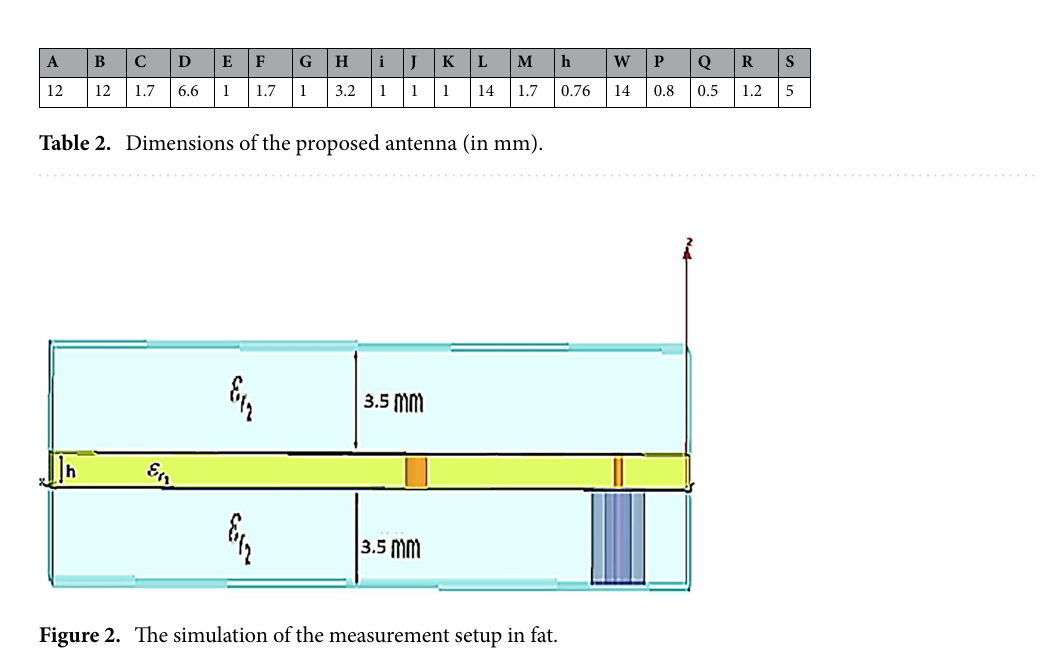
Figure 2. The simulation of the measurement setup in